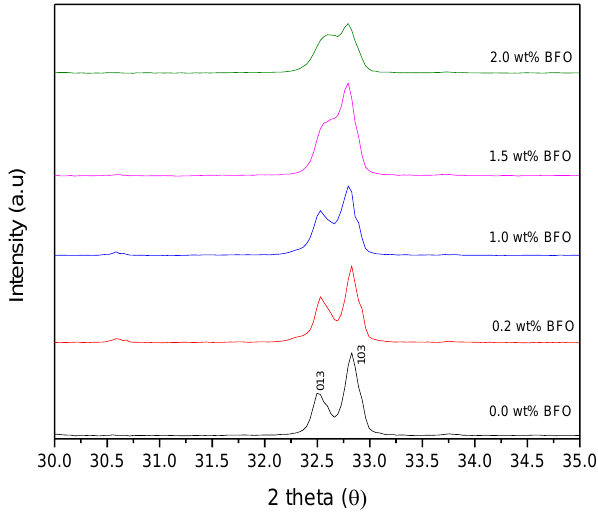
Figure 3. X-ray diffraction patterns corresponding to the [0 1 3] and [1 0 3] planes of the Y-123 for the Y-123 + x wt.% of